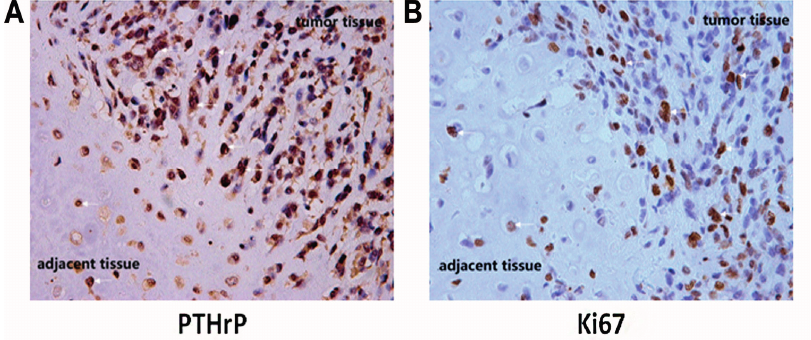
Figure 1. Human chondrosarcoma tissues expressed elevated level of parathyroid hormone-related protein (PTHrP) accompanied by strong proliferation ability. The white arrows refer to positive tumor cells. The left image ( A ) shows PTHrP expression in chondrosarcoma tumor tissue and adjacent tissue; The right image ( B ) shows the Ki67